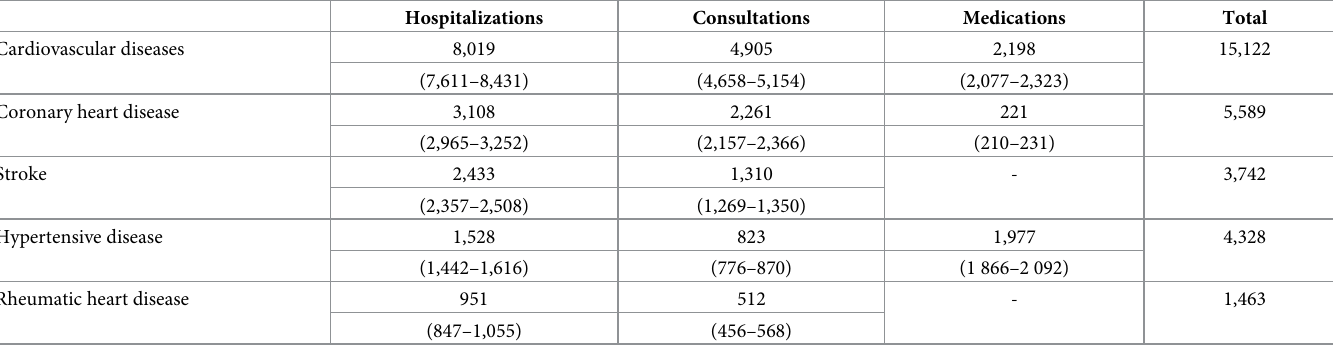
Table 2. Estimated total costs (thousand USD $) of cardiovascular disease hospitalizations, consultations, and medications, and losses of Gross Product by cardio- vascular disease type for CCSS attributable to excessive salt intake in Costa Rica, 2018 (95% uncertainty intervals).